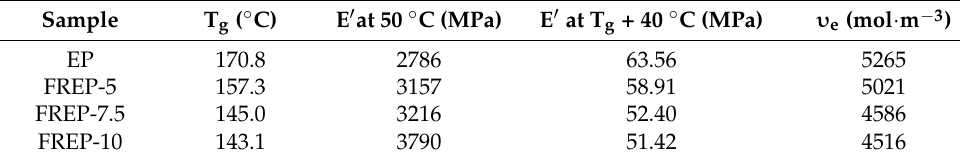
Figure 13. DMA curves of EP and FREPs, storage modulus ( a ), tan δ ( b ). Table 7. Thermomechanical properties of EP and FREPs.